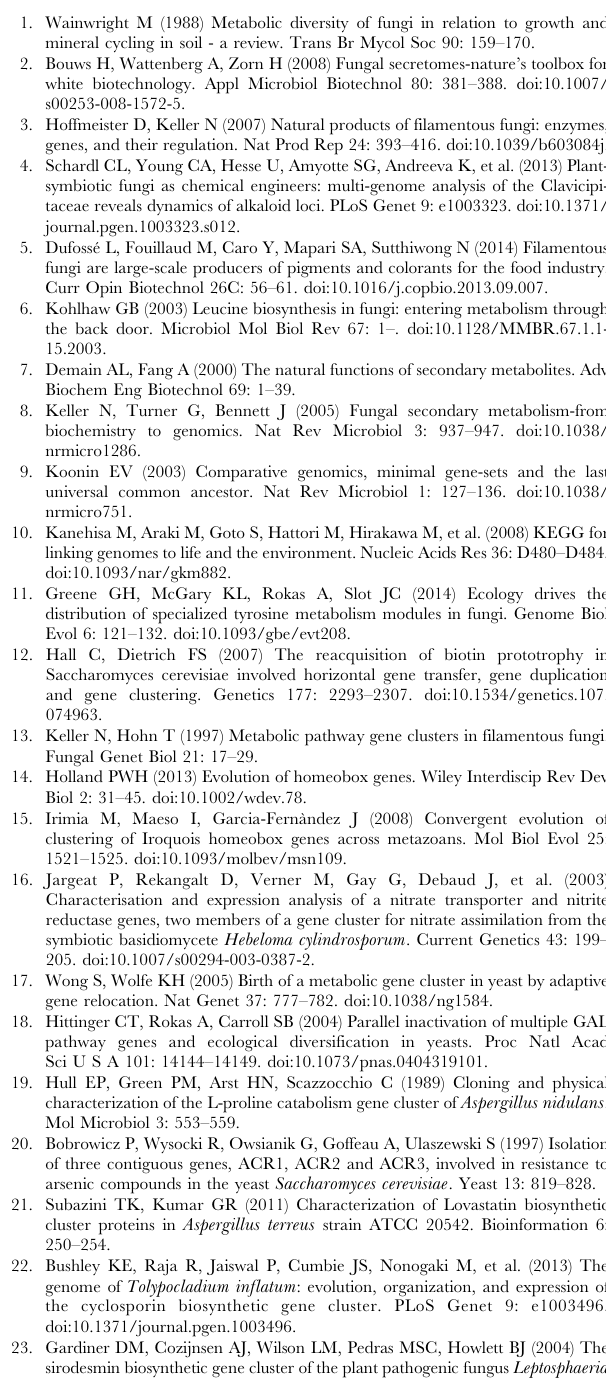
Table S9 Curation to species phylogeny with